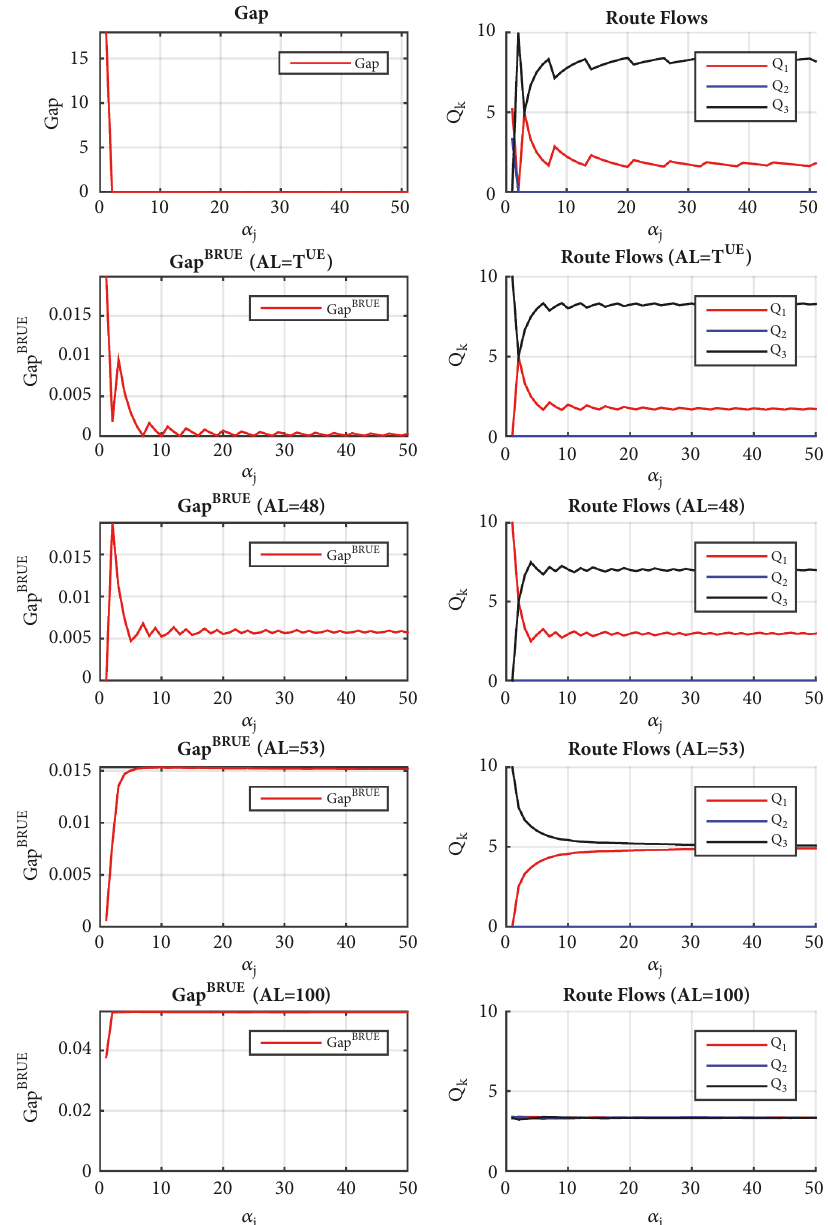
Figure 2: Gap (left) and route flows (right) as a function of the increasing number of MSA descent steps 𝑗 for the DUE and several values of 𝐴𝐿 𝑜𝑑 = 𝑇 𝑈𝐸 ,48,53, 100 .